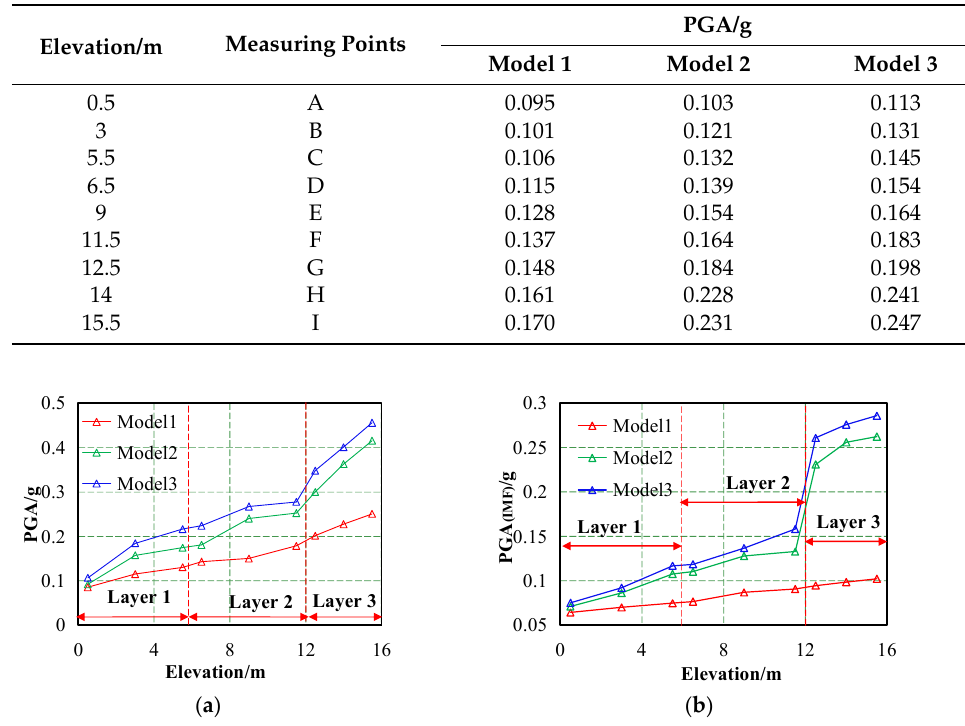
Figure 11. Change in PGA of the models when input in the x -direction: ( a ) PGA, ( b ) PGA (IMF) .